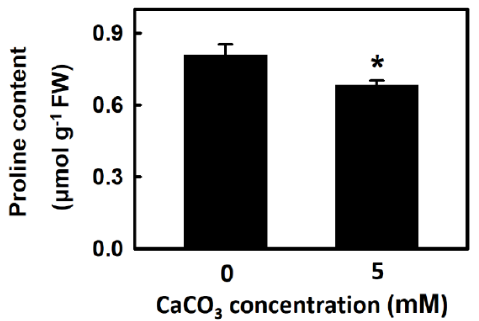
Figure 6. The effect of calcium carbonate on proline content of Djulis sprouts. The 7-d-old djulis plants were treated with 5 mM CaCO 3 for 5 days. The proline content of djulis were measured. Bars show means ± SE ( n = 4). * represent values that are significantly different between calcium carbonate concentration 0 mM and 5 mM at p < 0.05.